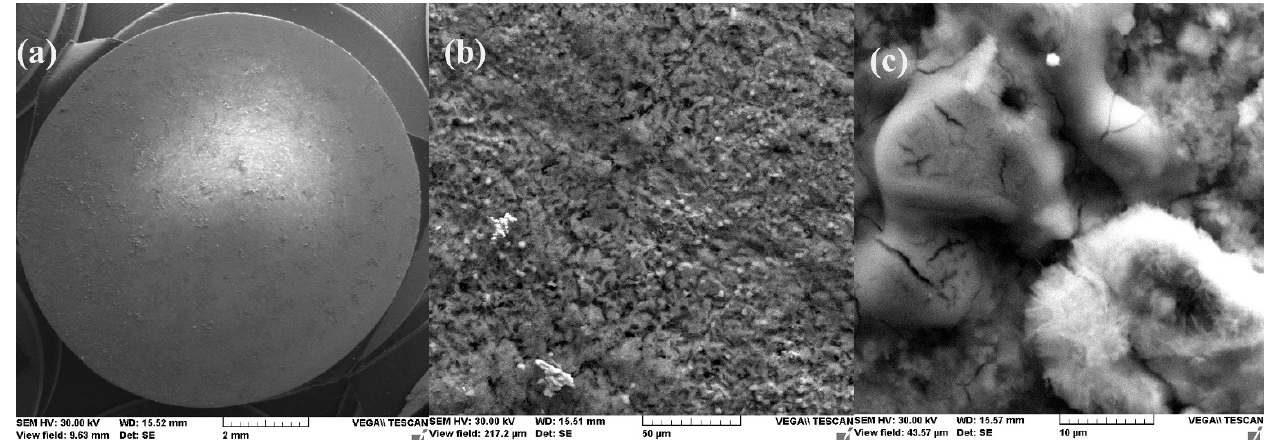
Figure 3. SEM microphotographs for C45 immersed 24 h in seawater ( a ) 100×, ( b ) 1000× and ( c ) 5000×. A more conclusive figure (Figure 4) was provided by the EDX determinations on a small portion of the surface (850 µm 2 ), on which the overall surface composition and point compositions on the main table and crystalline micro compounds were measured.